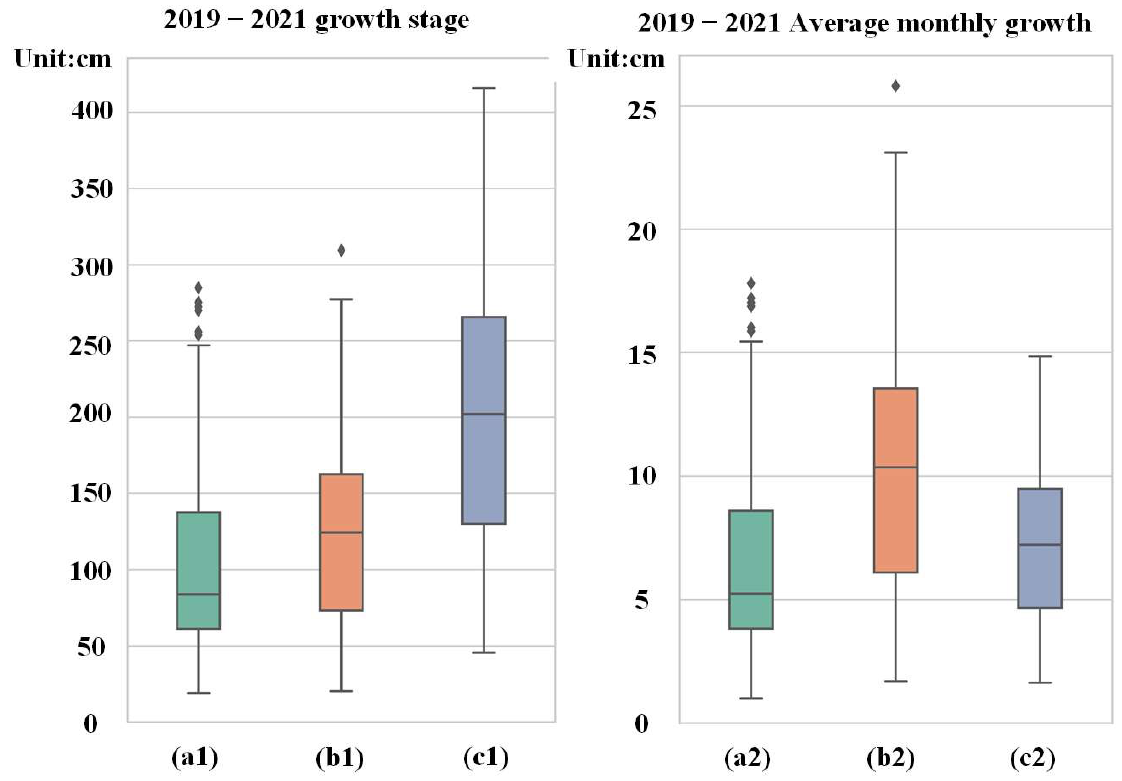
Figure 14. The left boxplot shows the annual growth of the saplings from 2019 to 2021, and the right boxplot shows the average monthly growth of the saplings each year. The colors of the boxplot show the different stages of young tree growth. Green shows the survival of young trees from June 2019